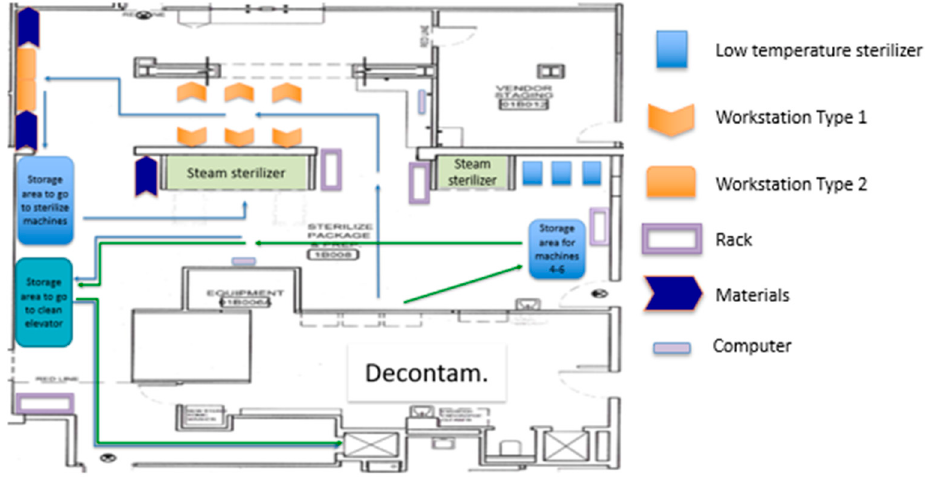
Figure 12. Proposed layout #3.